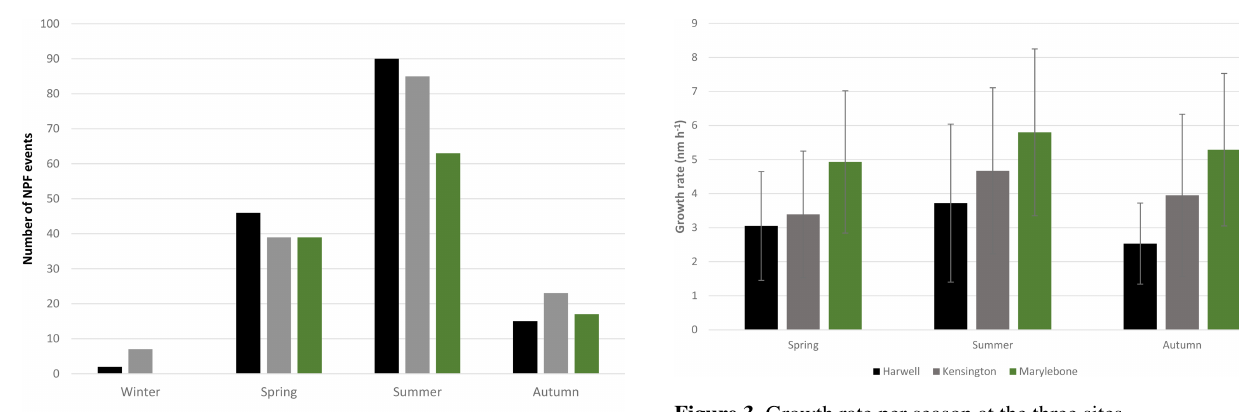
Figure 3. Growth rate per season at the three